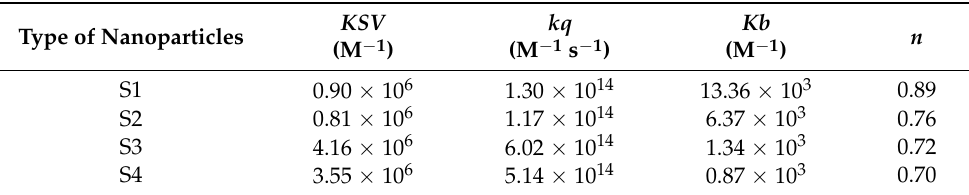
Table 4. The binding parameters of the interaction of the biogenic ferrihydrite nanoparticles from S1–S4 samples and